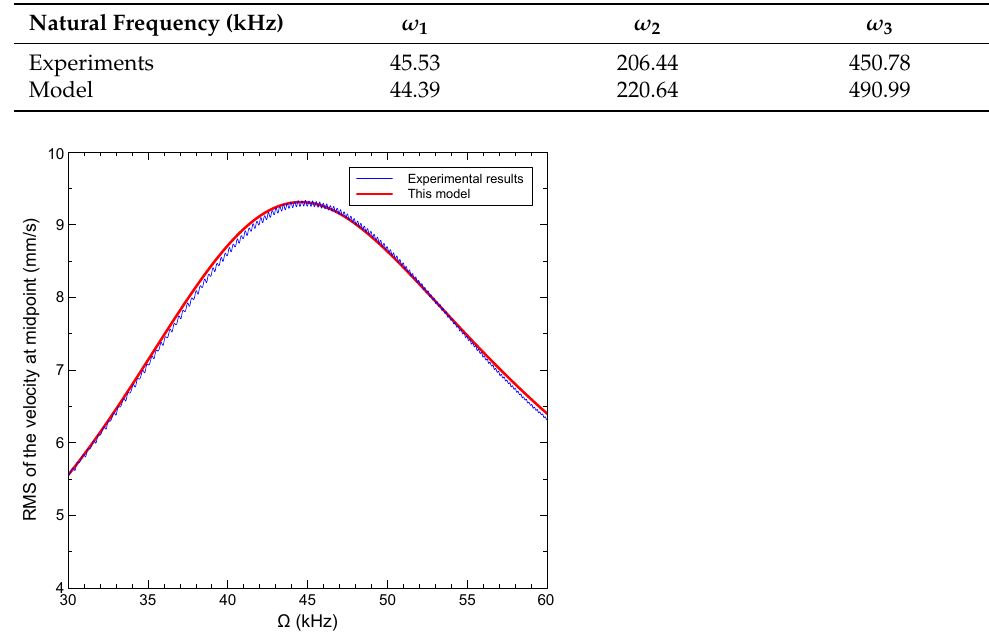
Figure 6. Frequency responses of the microbeam under half electode length actuation: model vs. experiments.